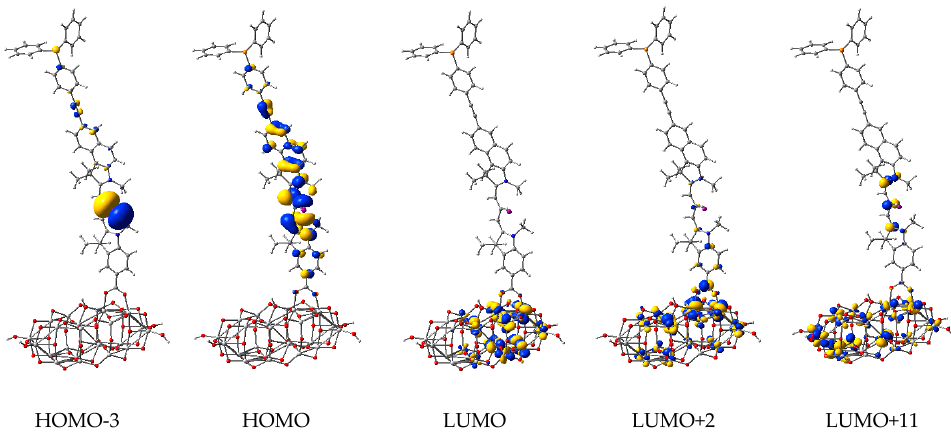
Figure 14. Isodensity surfaces (0.03 e/bohr 3 ) of the key molecular orbitals of the system consisting of the OMCD1 molecule adsorbed onto the Ti 24 O 50 H 4 cluster, calculated by DFT at the B3LYP/LANL2DZ level in water solvent. Atom colors: T, light grey; C, grey; O, red; N, blue; P, orange; I, purple; and H, small light grey.